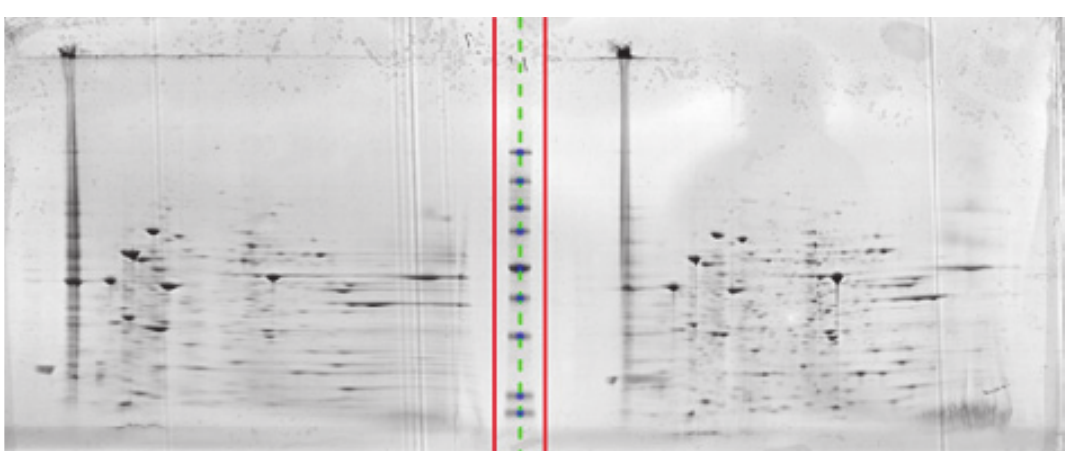
Fig. 4. Illustration of protein standard MW marker identification result on one of the 2DE gel images in the test